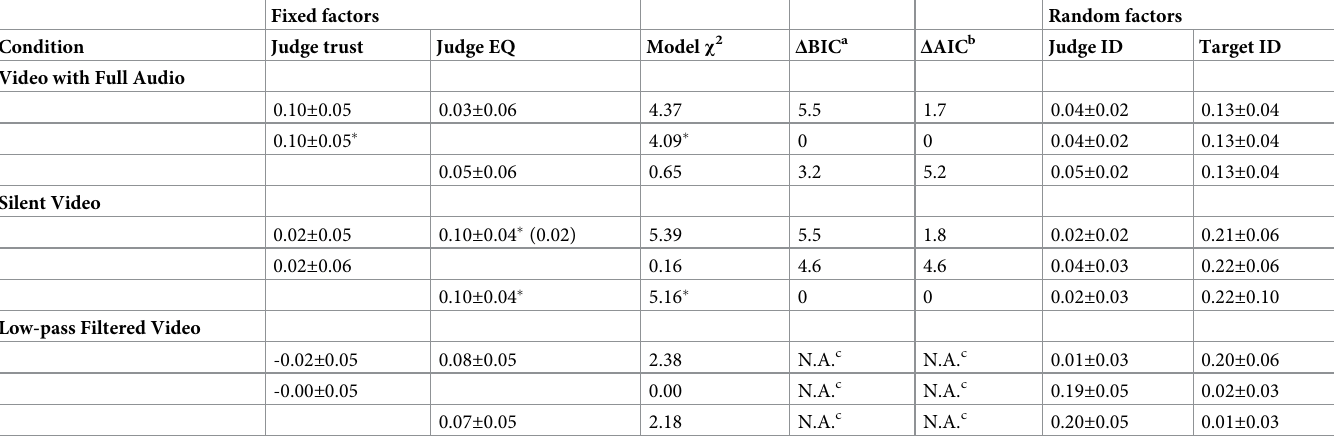
Table 7. Multilevel mixed regression models predicting absolute value of LORP-LSRP difference for primary psychopathy.